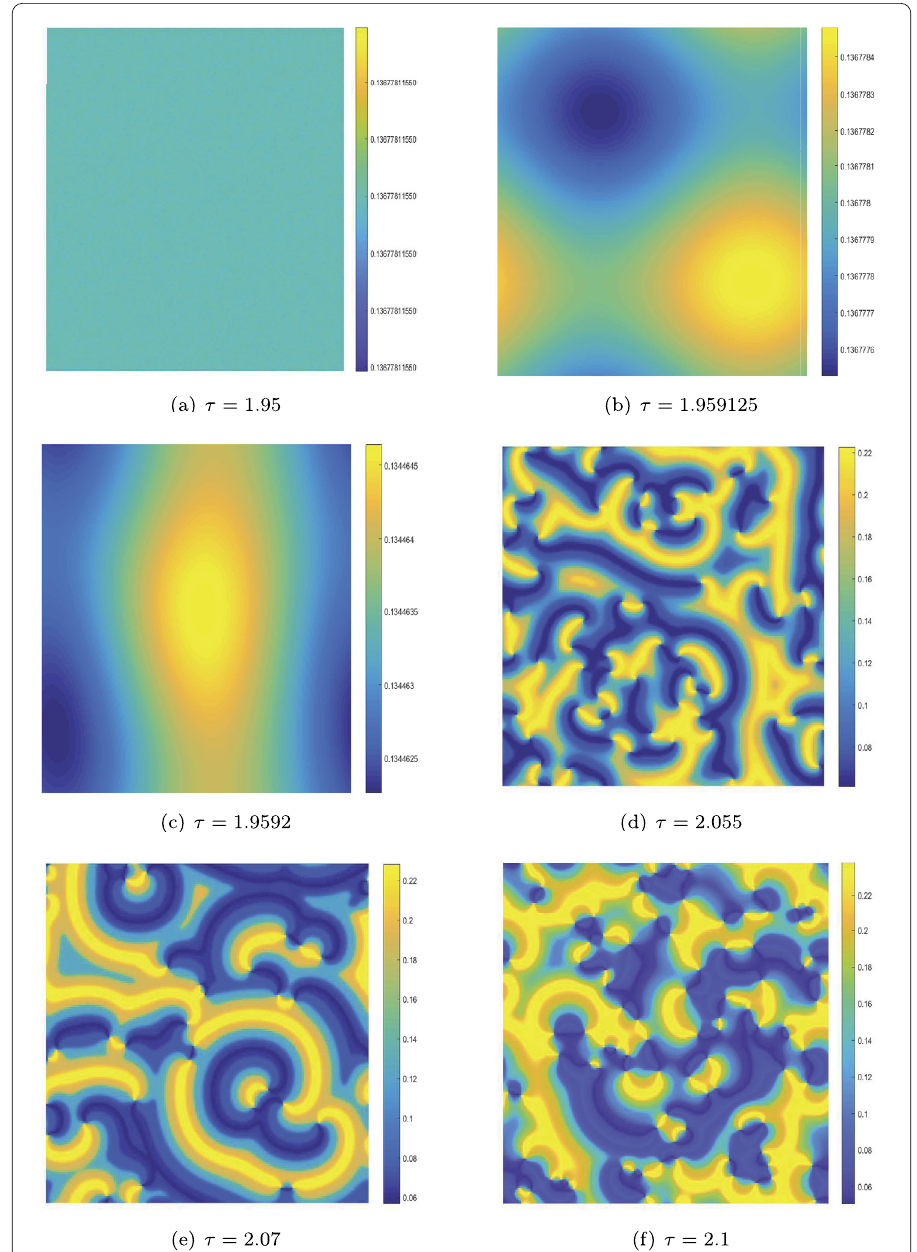
Figure 13 Spatial patterns of W self-organized under pure-Turing and Neimark–Sacker–Turing instability on 200 × 200 lattices